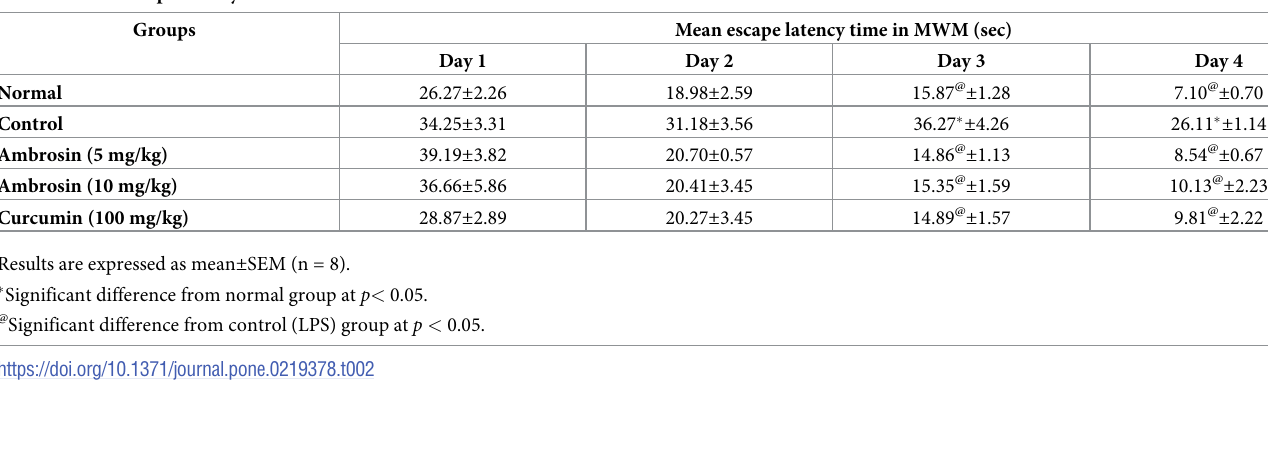
Table 2. Mean escape latency time in the